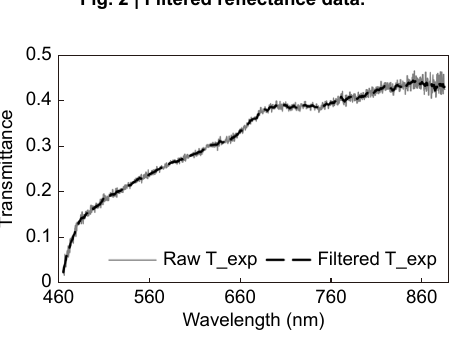
Fig. 2 | Filtered reflectance data.